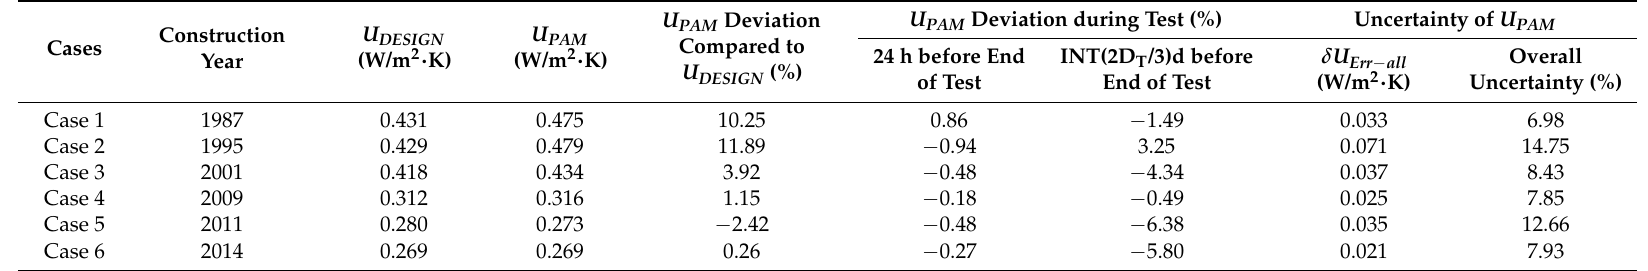
Table 2. Comparison of design U -values and in situ U -values analyzed by progressive average method, and overall uncertainties due to measuring-device error.